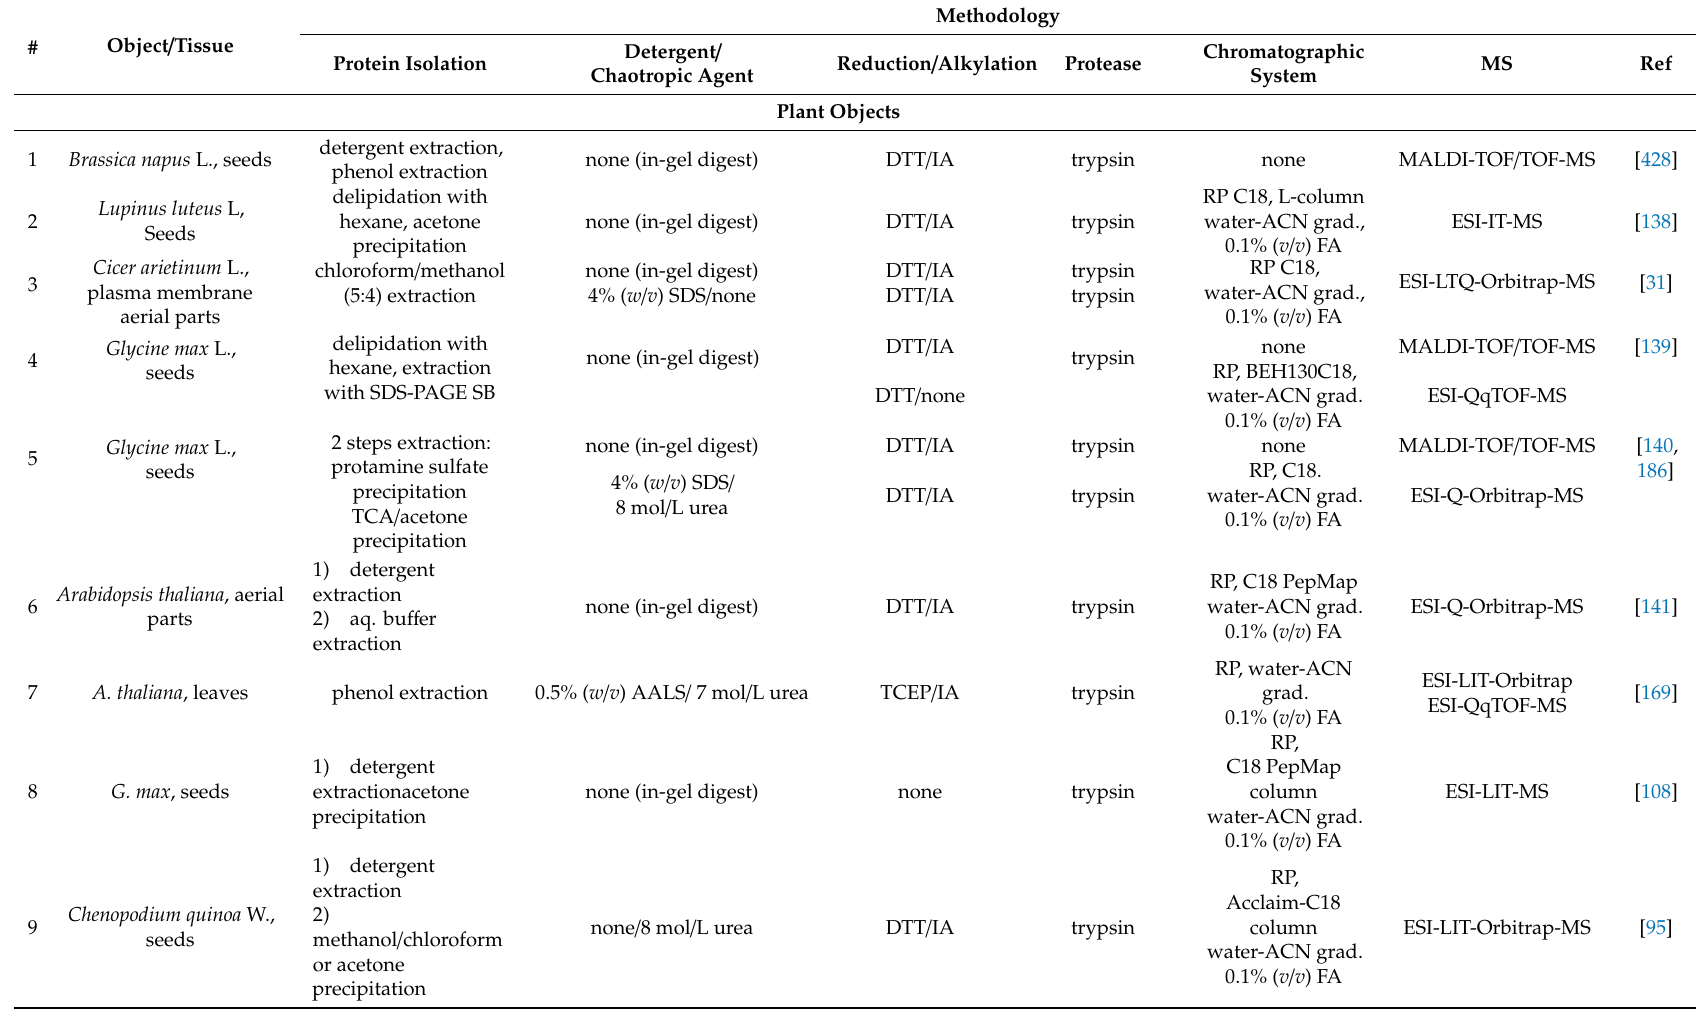
Table A2. Digestion strategies used in bottom-up